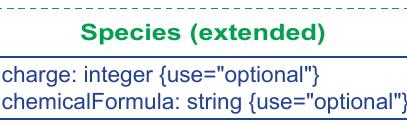
Figure 3: A UML representation of the extended SBML Species class used in the Flux Balance Constraints package. See Section 1.4 for conventions related to this figure. The charge attribute